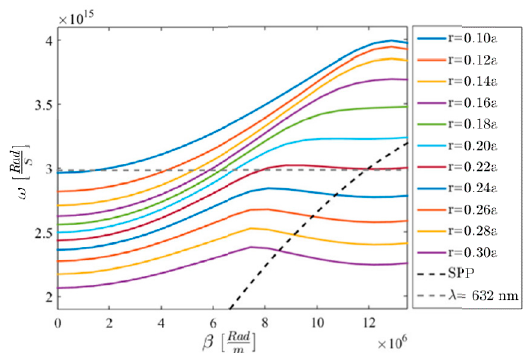
Figure 4. Dispersion diagrams of waveguides obtained by removing one r w of pillars in 2D hexagonal PhC. The radius of Si pillars are varied from r = 0.1a to r = 0.3a. The dashed black graph shows the dispersion diagram of the SPP mode of a 40-nm gold film sandwiched between air and glass substrate. The grey dotted line represents the frequency corresponding to λ = 632 nm.